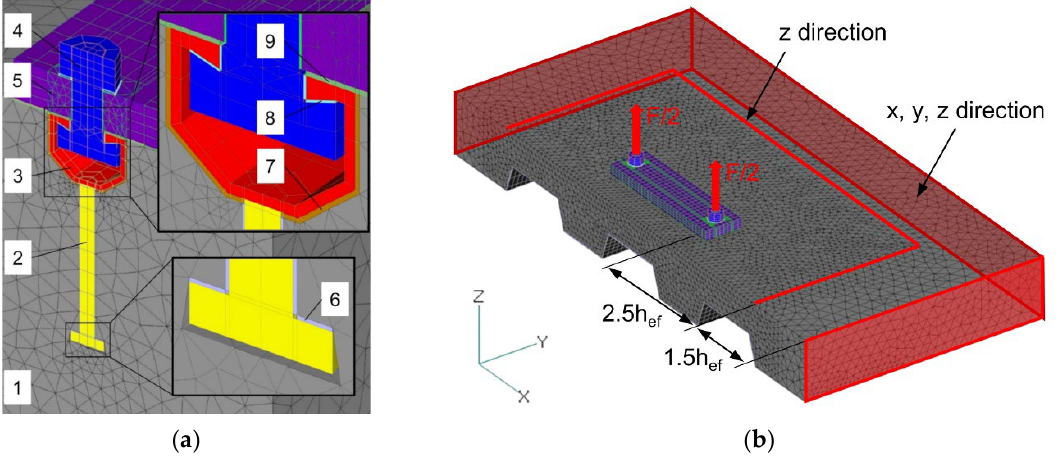
Figure 3. ( a ) FE discretization: 1—concrete slab, 2—anchor, 3—channel, 4—T-bolt with nut, 5—fixture, 6—anchor interface, 7—channel interface, 8—T-bolt interface, 9—PTFE sheet; ( b ) FE model and boundary conditions.